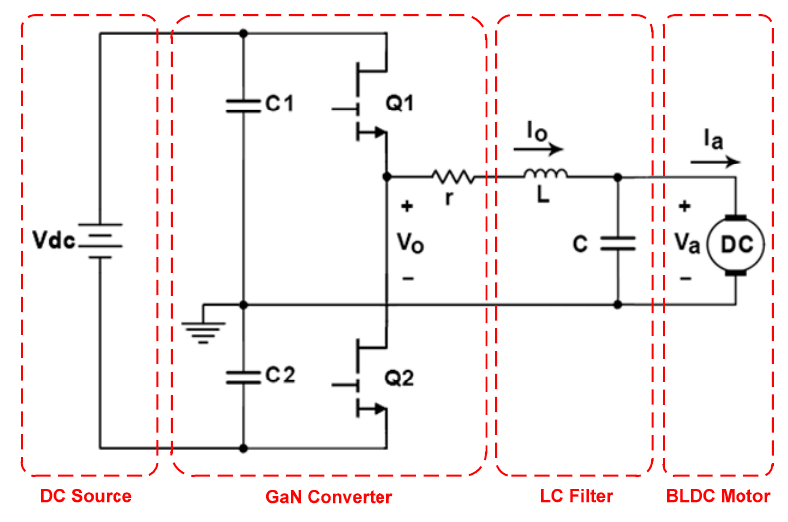
Figure 2. Electrical equivalent circuit.